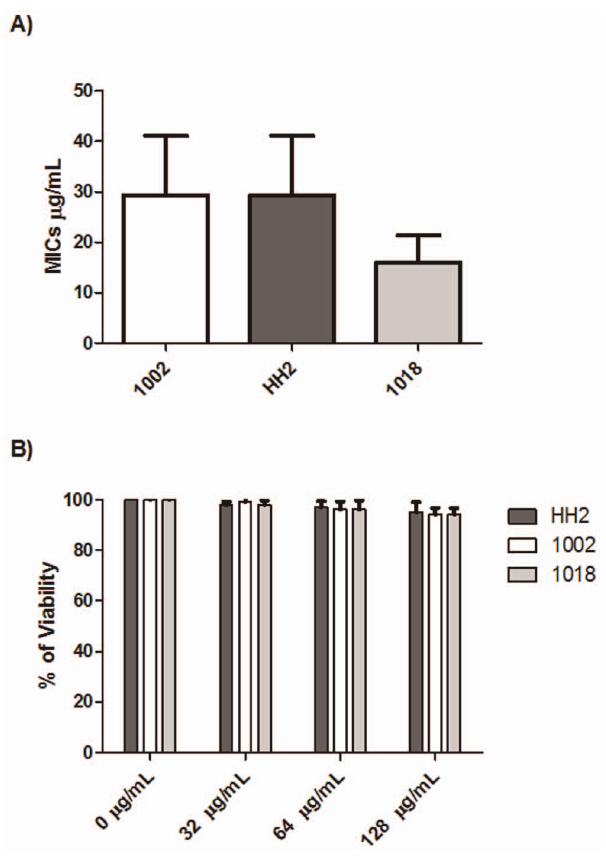
Figure 2. Effect of IDR peptides on the growth of M.tuberculosis and cytotoxicity in monocytic cells. (A) Mycobacterium tuberculosis strain H37Rv was incubated with increasing concentrations of the indicated peptides in doubling dilutions ranging from 128 to 8 m g/mL to determine the minimal inhibitory concentration (MIC). (B) The effect on monocyte viability was assessed by incubating increasing concen- trations of these peptides with cells and assessing the integrity of the cytoplasmic membrane. The data is expressed as means 6 standard deviation of 6 independent experiments with each one performed in